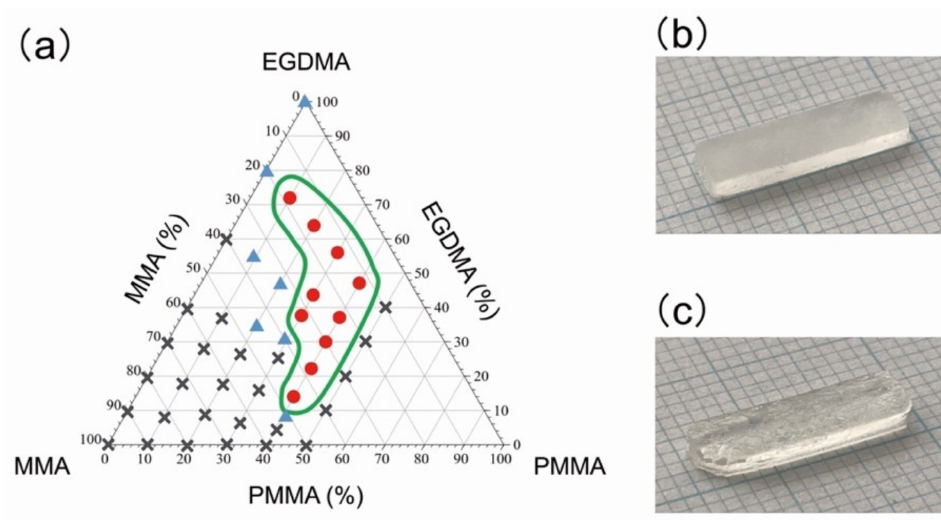
Figure 1. Printability of the PMMA-based resins for the SLA 3D-printing. ( a ) Phase diagram of the resin containing MMA, EGDMA, and PMMA. The symbols in the diagram denote printability; More than 29 of the 36 printed samples were fabricated successfully, ∆ : 4–28 per 36 samples were successful. × : 3 or fewer of the 36 samples were successful. Photographs of ( b ) successful and ( c ) failed printed